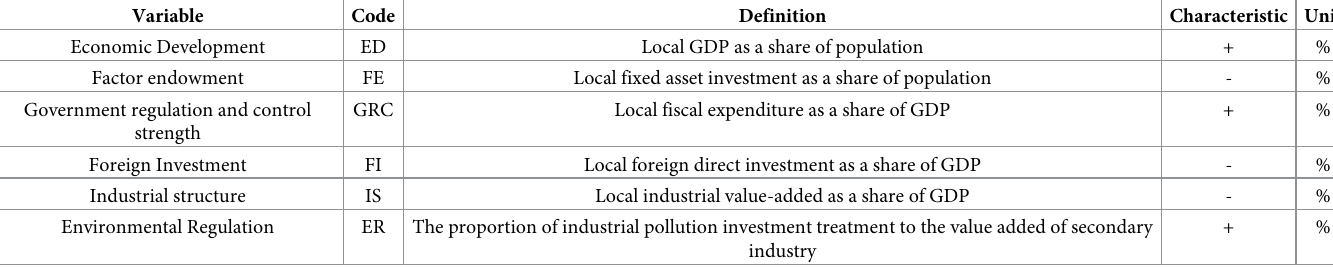
Table 5. Index of influencing factors of industrial eco-efficiency in the Yangtze River Economic